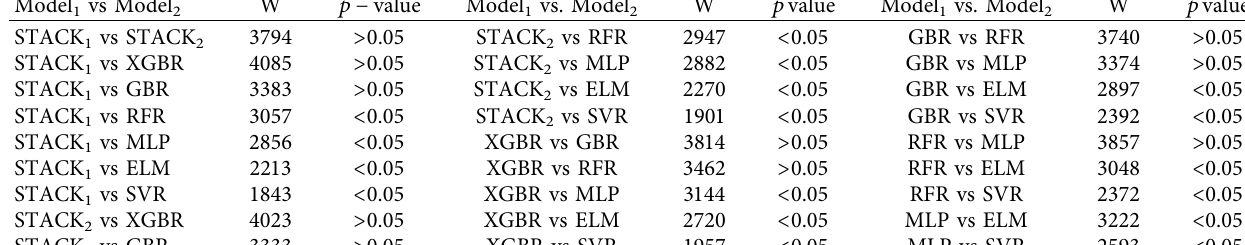
Table 8: Wilcoxon signed rank test statistic (W) (lower tail) and p value for APE